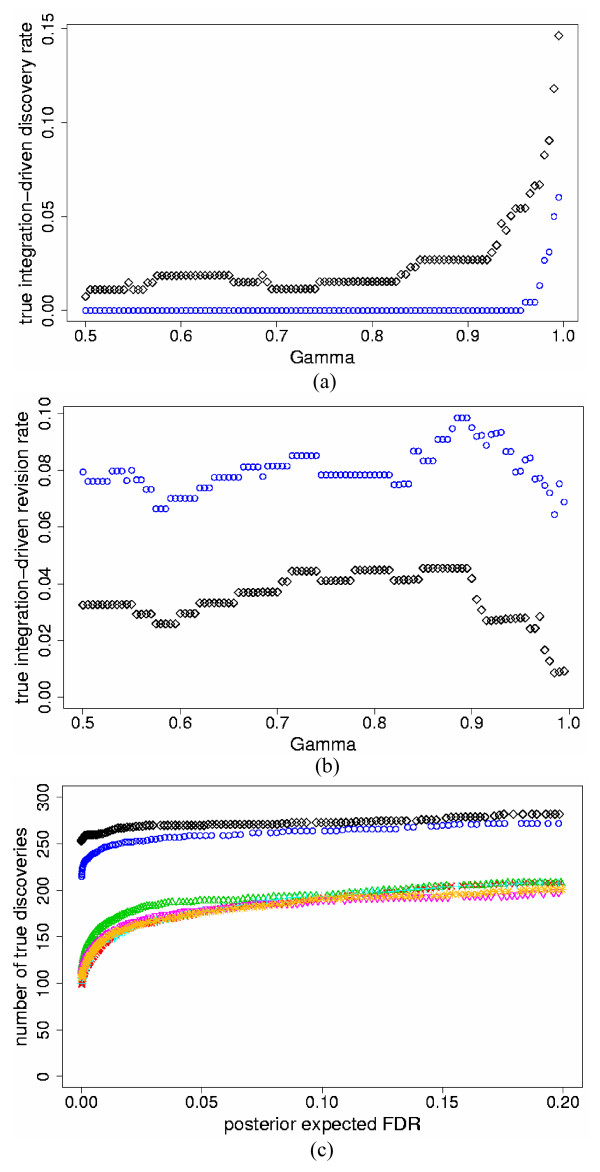
tIDR, tIRR and true discovered genes versus peFDR for the five-study simulation data. a) True integration-driven discovery rate (tIDR) versus threshold values of posterior probability of differential expression γ ≥ 0.50, for the standardized expression integration model (blue circles) and probability integration model (black diamonds) for the five-study simulation data with high mean τg2
 MathType@MTEF@5@5@+=feaafiart1ev1aaatCvAUfKttLearuWrP9MDH5MBPbIqV92AaeXatLxBI9gBaebbnrfifHhDYfgasaacH8akY=wiFfYdH8Gipec8Eeeu0xXdbba9frFj0=OqFfea0dXdd9vqai=hGuQ8kuc9pgc9s8qqaq=dirpe0xb9q8qiLsFr0=vr0=vr0dc8meaabaqaciaacaGaaeqabaqabeGadaaakeaaiiGacqWFepaDdaqhaaWcbaGaem4zaCgabaGaeGOmaidaaaaa@30EE@ = 0.7 (differentially expressed); 0.07 (non-differentially expressed) and simulated percent differentially expressed genes ps = 10%; b) True integration-driven revision rate (tIRR) versus threshold values of posterior probability of differential expression γ ≥ 0.50, for the standardized expression integration model (blue circles) and probability integration model (black diamonds) for the five-study simulation data with high mean τg2
 MathType@MTEF@5@5@+=feaafiart1ev1aaatCvAUfKttLearuWrP9MDH5MBPbIqV92AaeXatLxBI9gBaebbnrfifHhDYfgasaacH8akY=wiFfYdH8Gipec8Eeeu0xXdbba9frFj0=OqFfea0dXdd9vqai=hGuQ8kuc9pgc9s8qqaq=dirpe0xb9q8qiLsFr0=vr0=vr0dc8meaabaqaciaacaGaaeqabaqabeGadaaakeaaiiGacqWFepaDdaqhaaWcbaGaem4zaCgabaGaeGOmaidaaaaa@30EE@ = 0.7 (differentially expressed); 0.07 (non-differentially expressed) and simulated percent differentially expressed genes ps = 10%; c) The maximum number of true discovered genes versus posterior expected false discovery rate (peFDR) for the standardized expression integration model (blue circles), probability integration model (black diamonds), individual analyses of Study 1 (red checks), Study 2 (green triangles), Study 3 (turquoise pluses), Study 4 (pink inverted triangles), Study 5 (gold stars) for the five-study simulation data with high mean τg2
 MathType@MTEF@5@5@+=feaafiart1ev1aaatCvAUfKttLearuWrP9MDH5MBPbIqV92AaeXatLxBI9gBaebbnrfifHhDYfgasaacH8akY=wiFfYdH8Gipec8Eeeu0xXdbba9frFj0=OqFfea0dXdd9vqai=hGuQ8kuc9pgc9s8qqaq=dirpe0xb9q8qiLsFr0=vr0=vr0dc8meaabaqaciaacaGaaeqabaqabeGadaaakeaaiiGacqWFepaDdaqhaaWcbaGaem4zaCgabaGaeGOmaidaaaaa@30EE@ = 0.7 (differentially expressed); 0.07 (non-differentially expressed) and simulated percent differentially expressed genes ps = 10%.